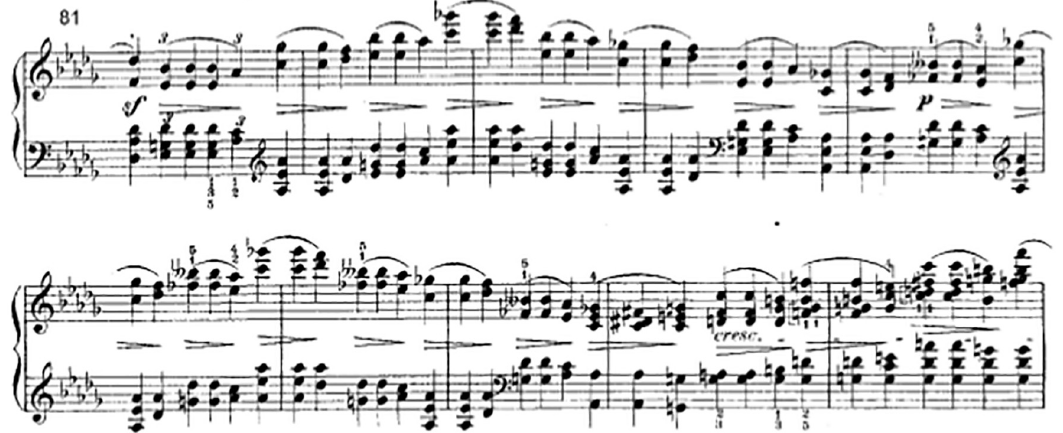
Fig 14. F. Chopin, Piano Sonata b flat minor op. 35, first movement: A different meaning of diminuendo symbols (edition [32], in the public domain).